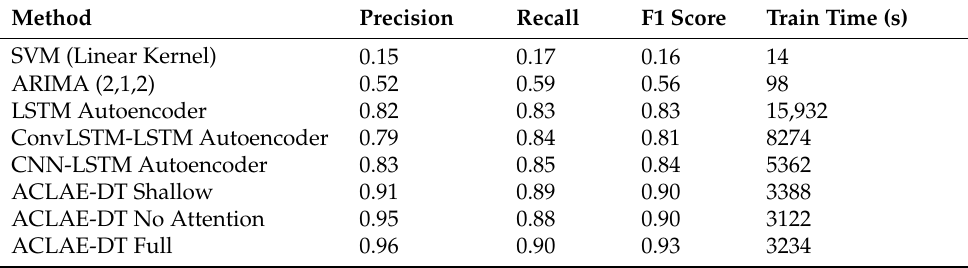
Table 3. Anomaly detection results using a window size of 30 with a step size of 5. Method